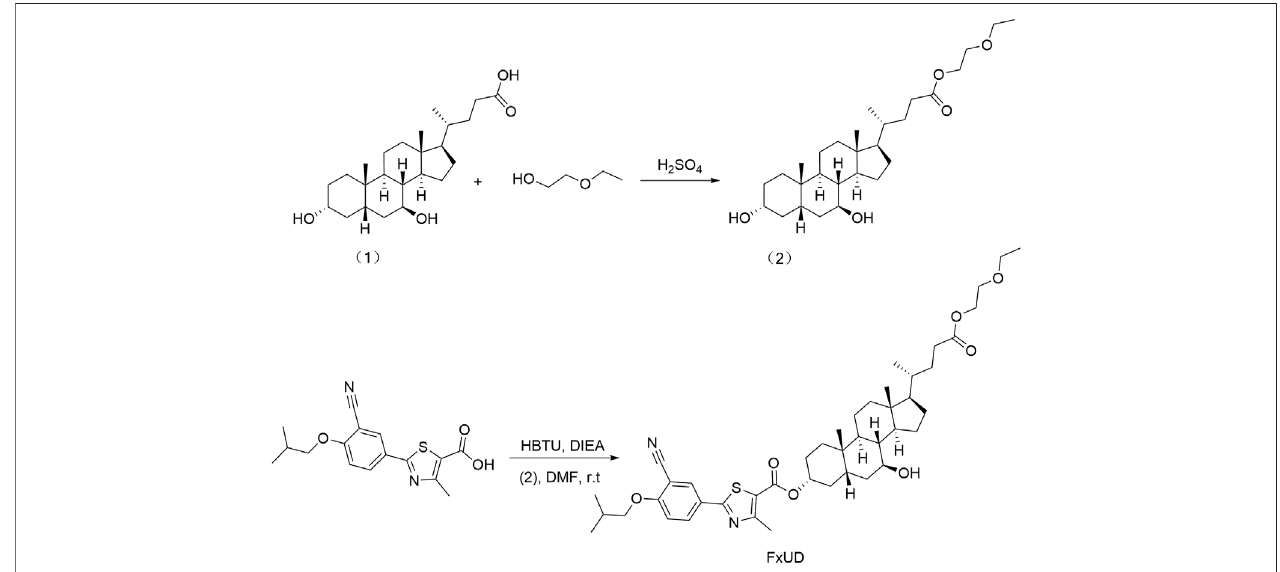
FIGURE 1 | The synthetic route of the novel compound named